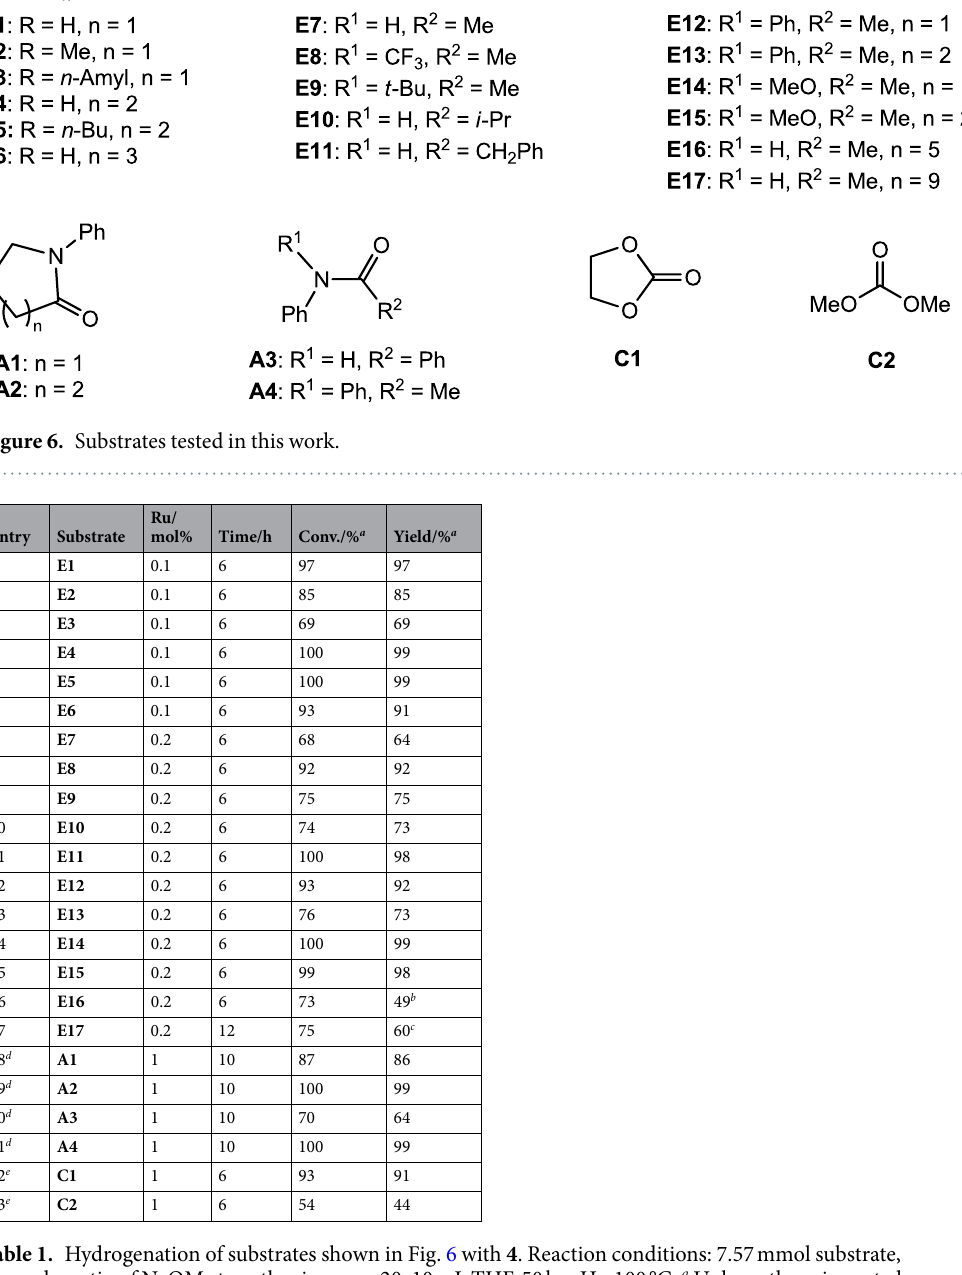
Table 1. Hydrogenation of substrates shown in Fig. 6 with 4 . Reaction conditions: 7.57 mmol substrate, the molar ratio of NaOMe to ruthenium was 20, 10 mL THF, 50 bar H 2 , 100 °C. a Unless otherwise noted, conversion of substrate and yield of alcohol were analyzed by gas chromatograph (GC). b 24% fatty-fatty esters present. c 14% fatty-fatty esters present. d Carboxamide conversion and alcohol yield were analyzed by 1 H NMR spectroscopy. e 120 °C, NaOEt was